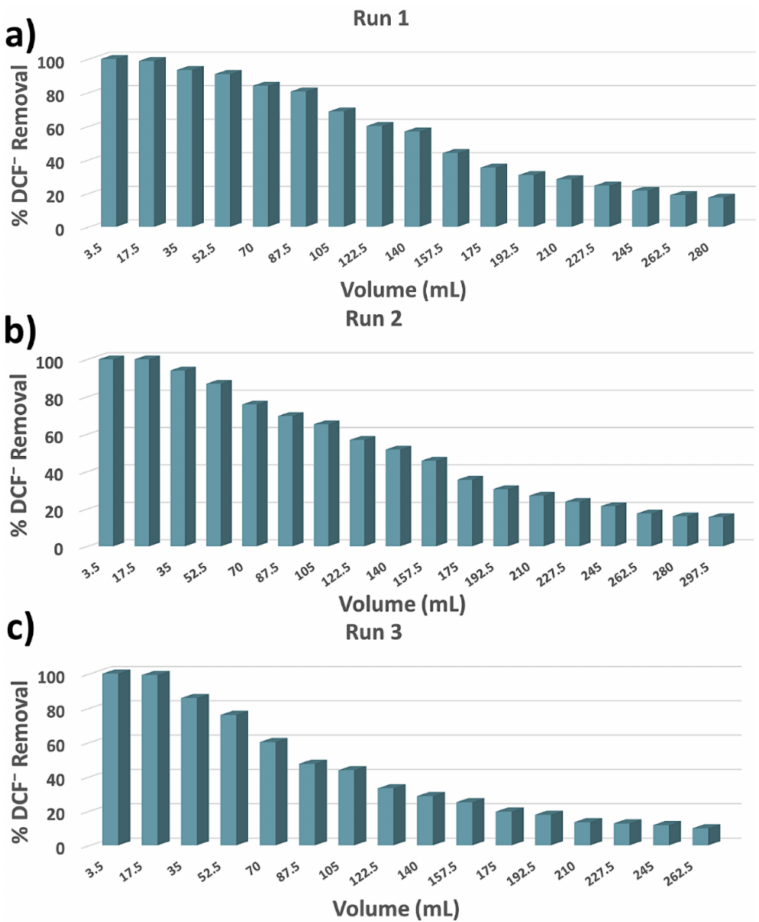
Figure 5. ( a ) The 1st run, ( b ) 2nd run, and ( c ) 3rd run of DCF − sorption under continuous flow conditions for MOR-1 - HA (initial DCF − concentration = 21